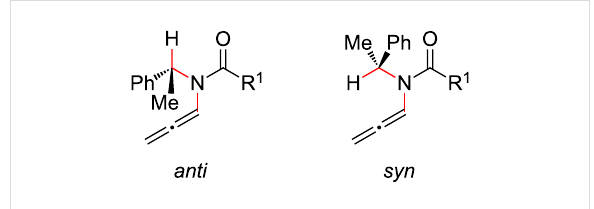
Figure 2: Anti and syn conformations around the N–C=C=C bond for N -allenyl compounds 12b – 14b